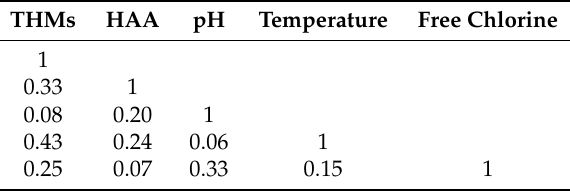
Table 5. Correlation matrix.